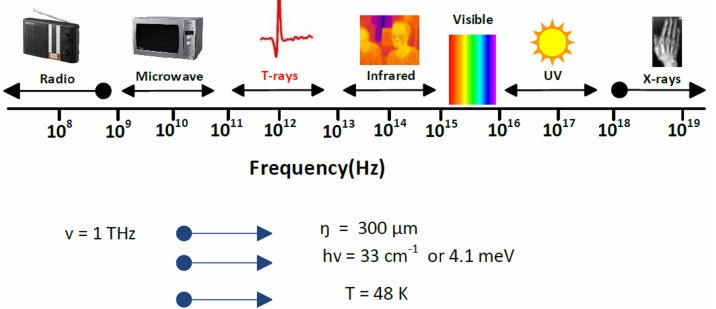
Figure 1. EM spectrum